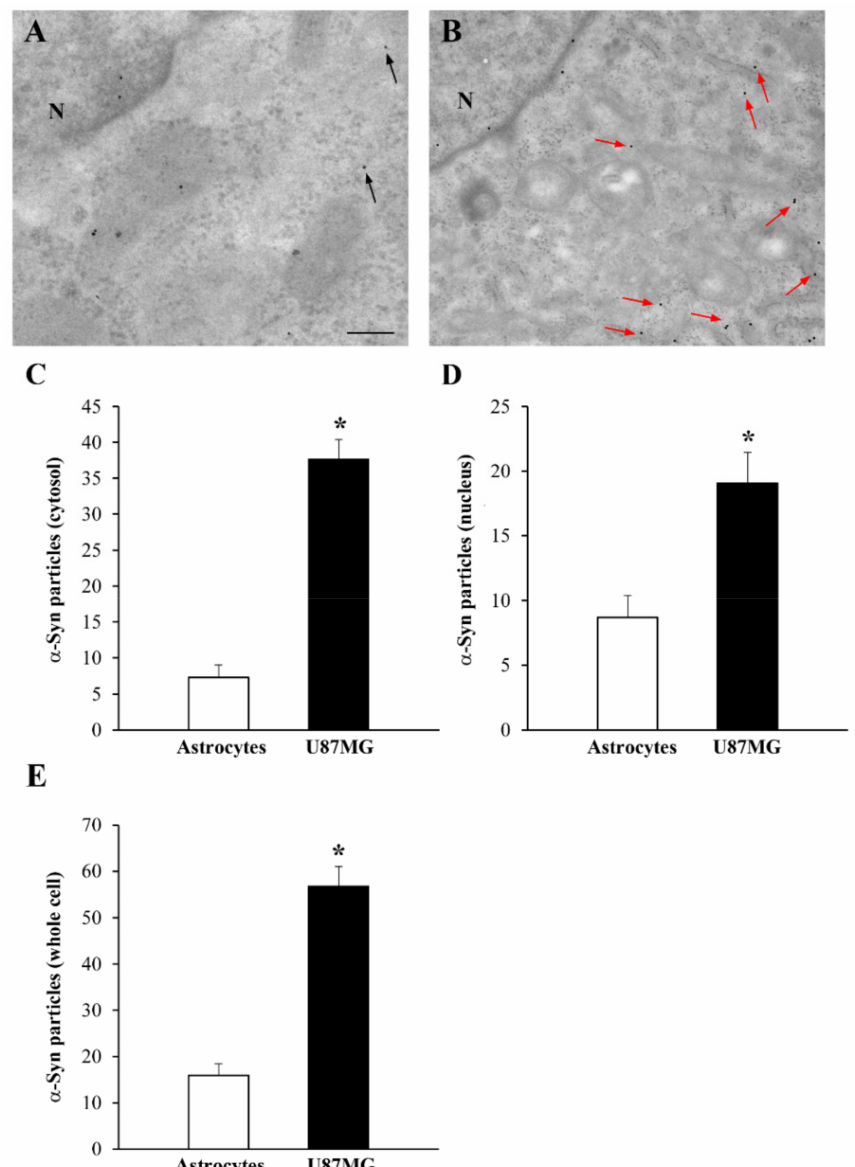
Figure 2. Occurrence and distribution of α -syn within U87MG cells and astrocytes. Representative electron micrographs of α -syn in astrocytes ( A ) and U87MG cells ( B ). In baseline conditions, a few scattered α -syn immuno-gold particles (black arrows) were found within the cytosol of astrocytes. In contrast, in U87MG cells, α -syn immuno-gold particles were abundant (red arrows). The rep- resentative distribution suggests that α -syn occurred within vacuoles in the cytosol of astrocytes, while it was uniformly dispersed in the cytosol of U87MG cells. Graphs report the number of α -syn immuno-gold particles within the cytosol ( C ), nucleus ( D ), and whole cell ( E ) within astrocytes, compared with U87MG cells. N = nucleus. Data are given as the mean ± SEM from n = 30 cells (astrocytes or U87MG cells) obtained in N = 3 independent experiments. * p < 0.05 compared with astrocytes. Scale bar = 0.11 µ